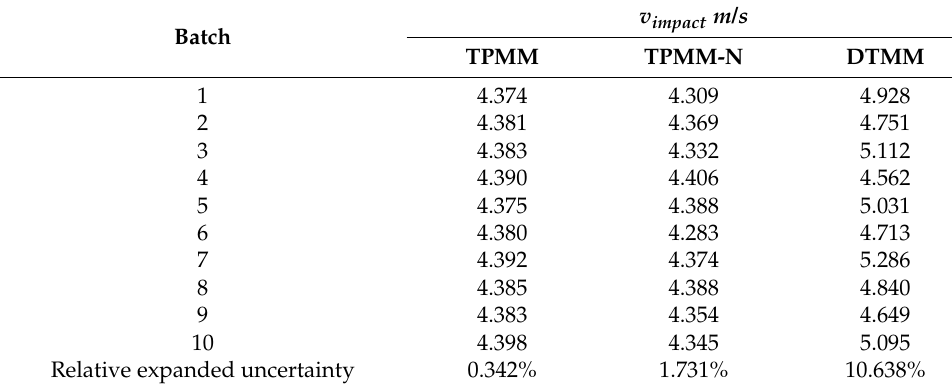
Table 4. Results of actual impact velocity measurement